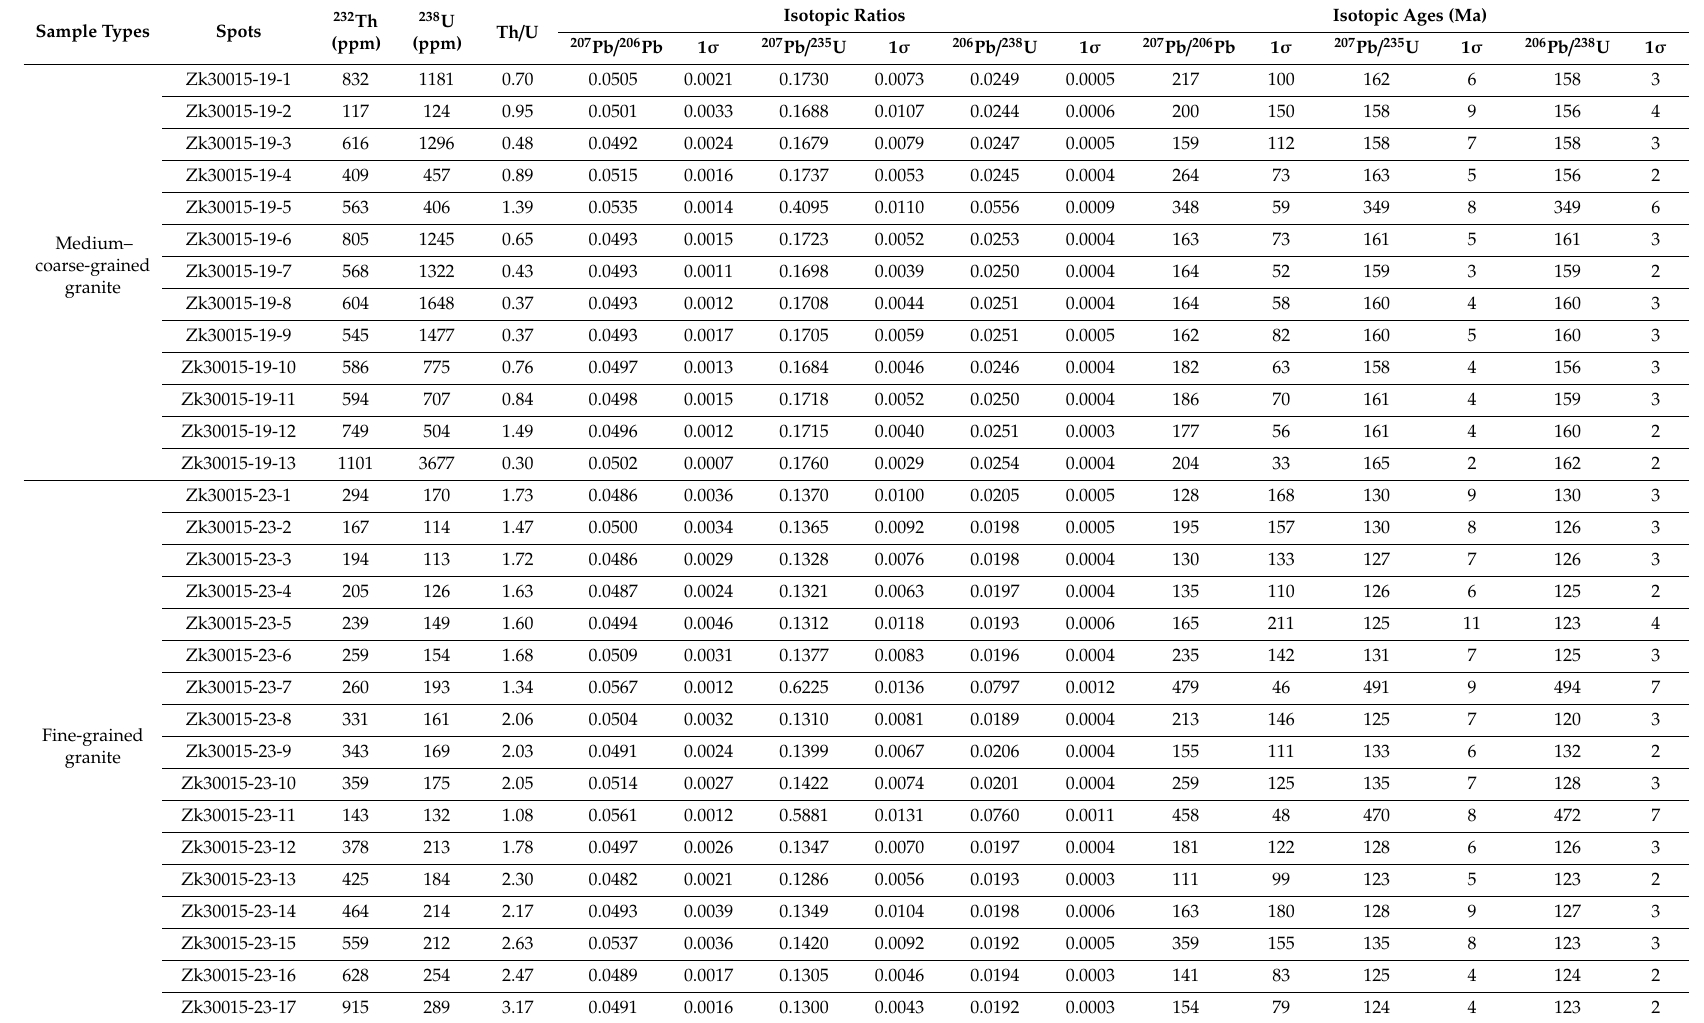
Table 1. LA-ICP-MS U–Pb dating results of zircon for granites in the Maoping W–Sn